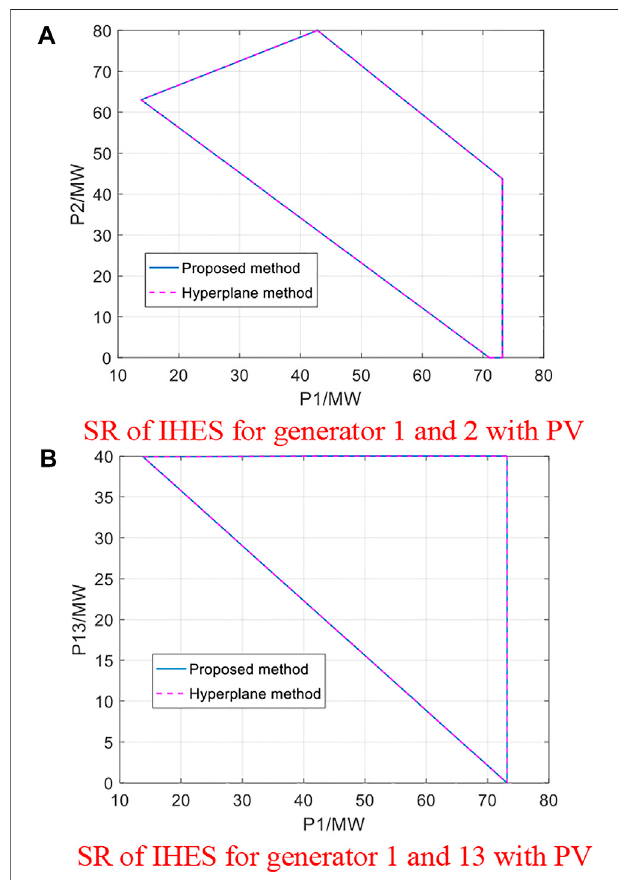
FIGURE 6 | Security region comparison between the proposed method and hyperplane